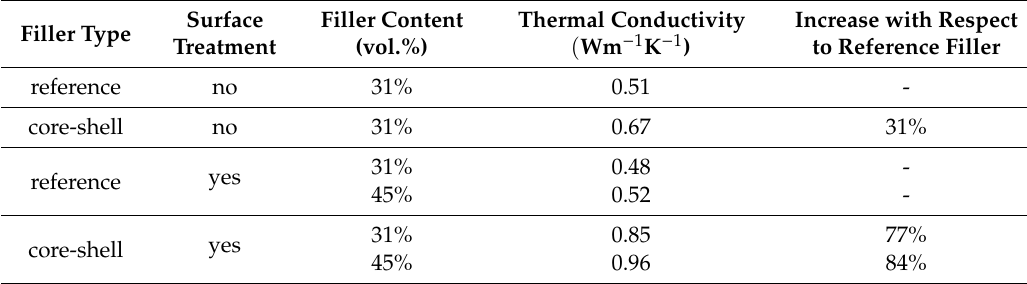
Table 1. Thermal conductivity results obtained at room